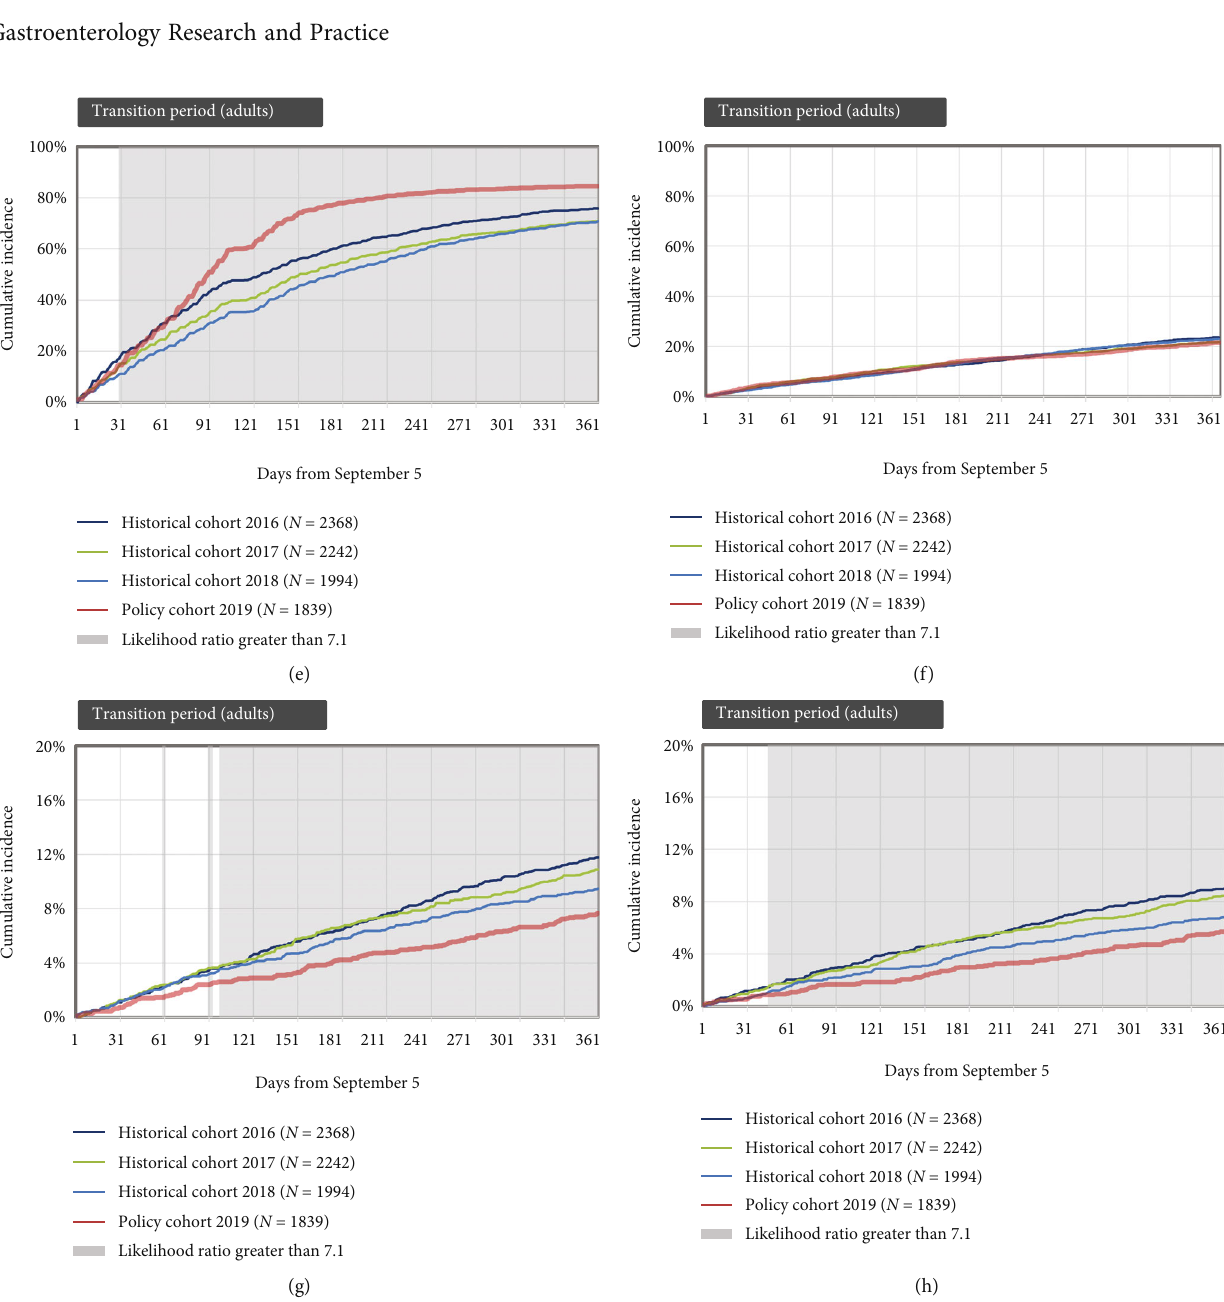
Figure 4: Cumulative incidence of health services outcomes, comparing the policy cohort and the three historical cohorts, for patients of all ages who were treated with in fl iximab for in fl ammatory bowel diseases. The health services outcomes are: (a) fi rst visit to a physician or nurse practitioner during the 1-year follow-up; (b) second visit to a physician or nurse practitioner; (c) third visit to a physician or nurse practitioner; (d) fourth visit to a physician or nurse practitioner; (e) fi rst visit to a gastroenterologist; (f) fi rst visit to the emergency department; (g) fi rst discharge from hospital; (h) emergency admission to a hospital. Daily likelihood ratios compared the cumulative incidence in the policy cohort to the average among the historical cohorts. A signal of an impact of the policy was de fi ned as likelihood ratios greater than 7.1 (shaded areas) that were sustained for at least 30 days. A transient e ff ect was de fi ned as a period of high likelihood ratios followed by a period in which the likelihood ratio was less than 7.1 (e.g., plate [b]). Transition periods are presented for adults who constituted most of the